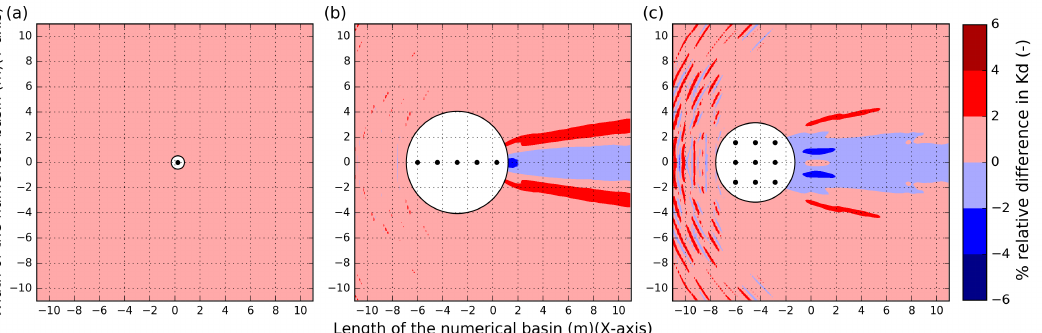
Figure 4. Relative difference (%) in K d , RD Kd , between the MILDwave-NEMOH coupled model and NEMOH for an irregular wave of T p = 1.26 s and H s = 0.104 m: ( a ) Test Case 2; ( b ) Test Case 4; and ( c ) Test Case 6 of Table 1. Contour levels are set at an interval of 2 of relative difference in K d value (-). The coupling region is masked out using a white solid circle which includes the WECs (indicated by using black solid circles). Incident waves are generated from the left to the